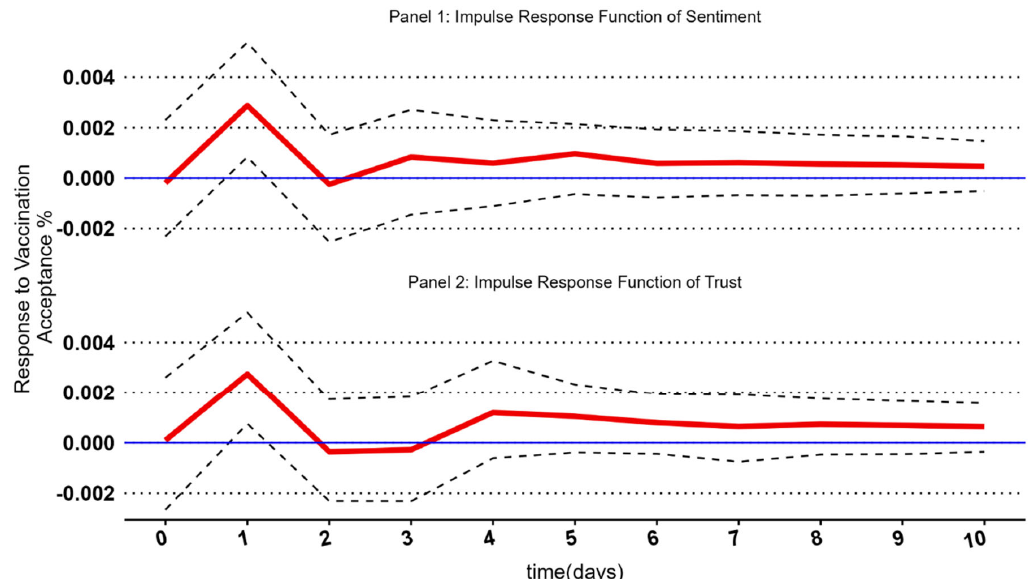
Figure 3. The impulse response function of two sentiment measurements of the COVID-19 vaccination cluster on the dependent variables. The IRF illustrates the response size of each shock to the system. The red line represents each lag’s main IRF point estimates. These can be interpreted as the effect of one standard deviation change.